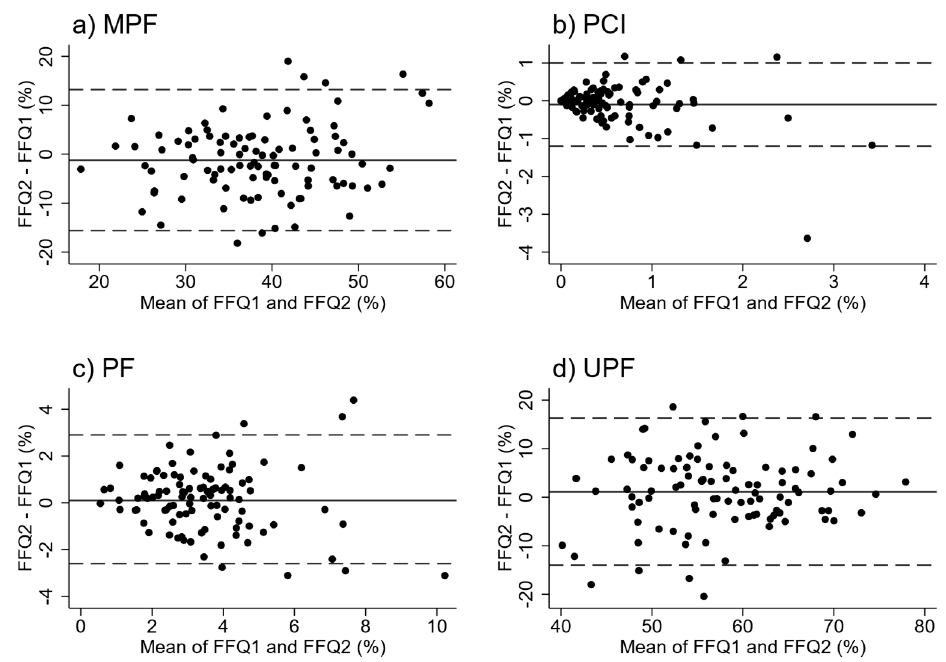
Figure 3. Bland–Altman plots for % energy intake between first and second administrations of FFQ: